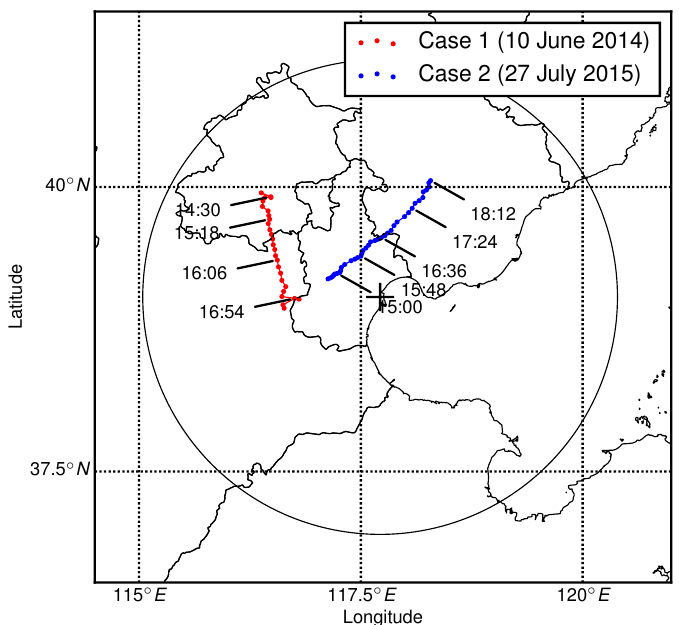
Figure 13. Cell movements of two example cases. The local time of several time steps is